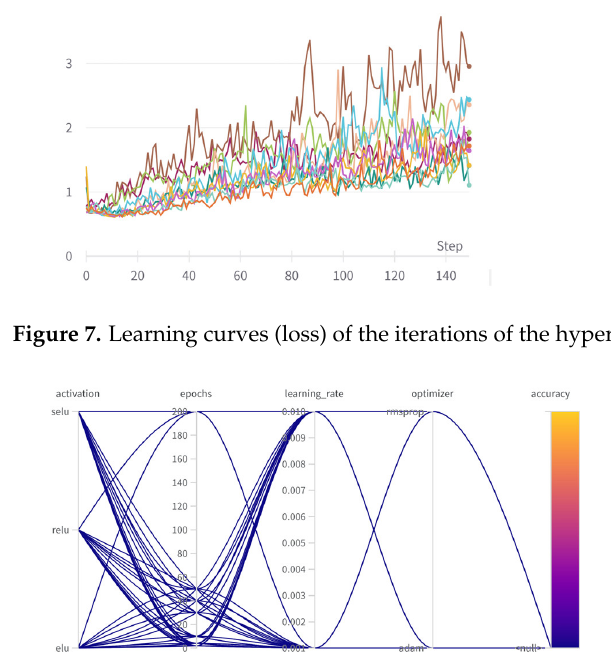
Figure 6. Learning curves (accuracy) of the iterations in the hyperparameter optimization.